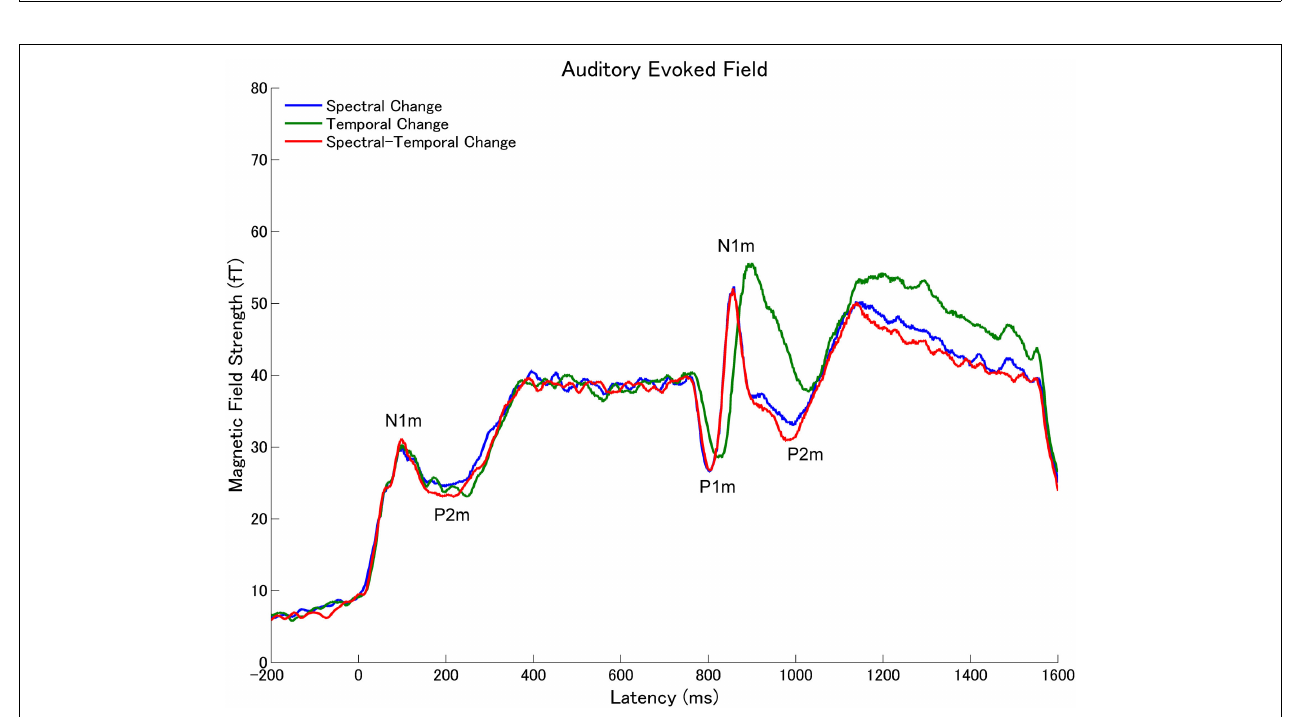
FIGURE 6 | Grand averaged root-mean-square (RMS) values of the magnetic fields of all sensors across all subjects ( N = 14) elicited by the band-pass filtered train pulses (Figure 2) in experiment 2 (arrangement according to Figure 5).